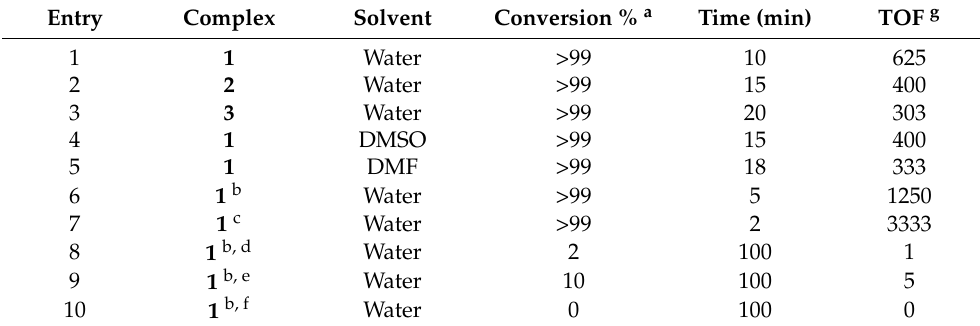
Table 1. Catalytic oxidation of benzyl